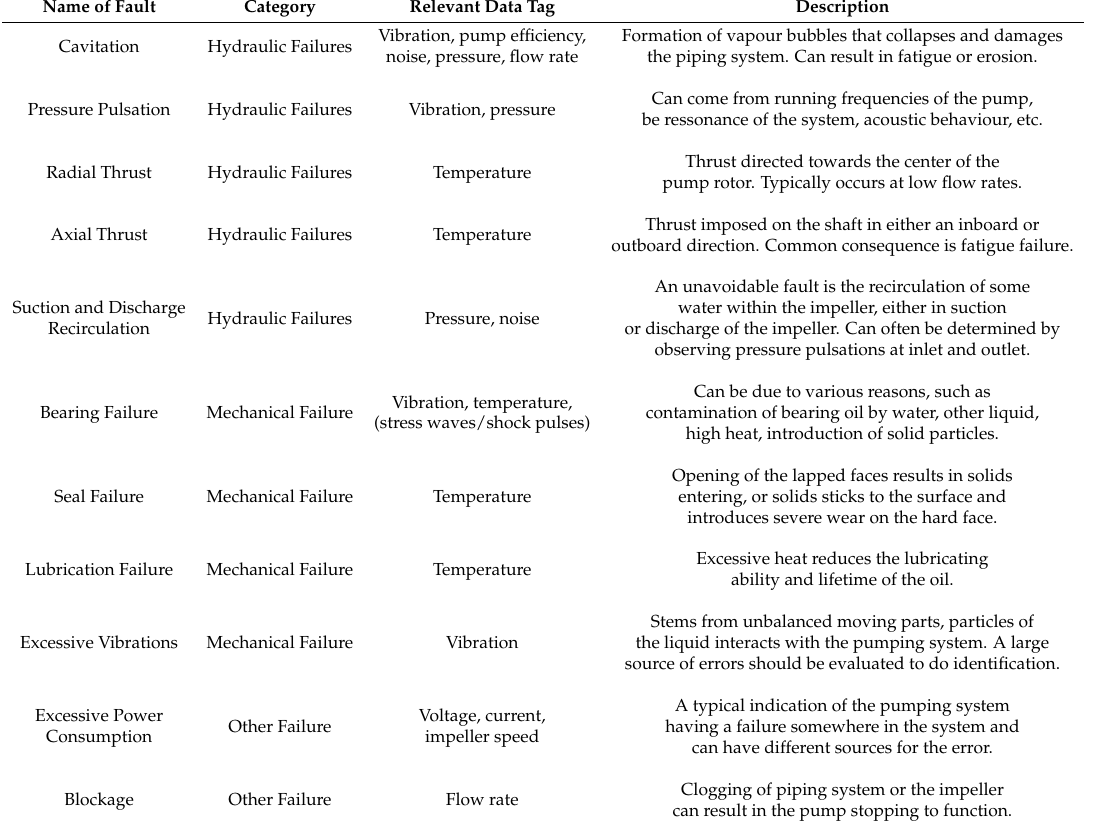
Table 4. Failure types by category for a centrifugal